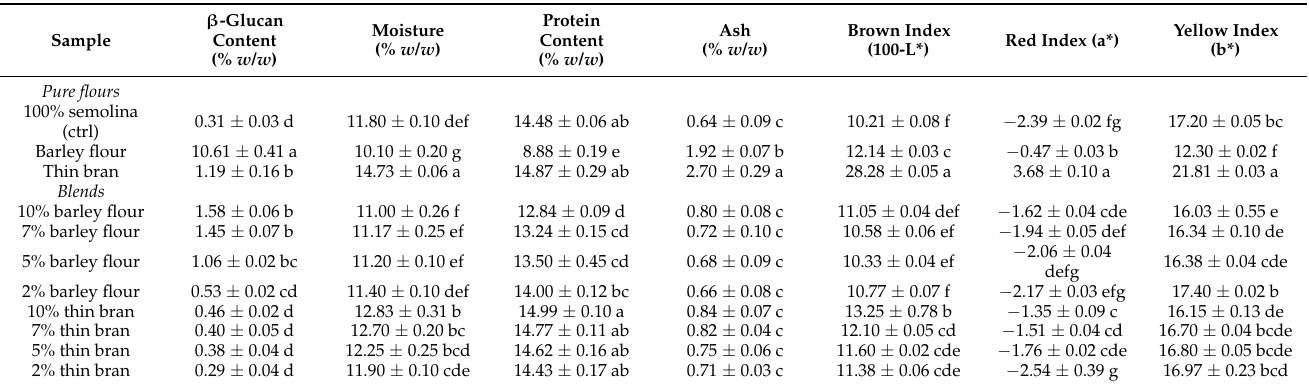
Table 1. Physicochemical features of raw materials and flour blends: one-factor ANOVA (analysis of variance) (data are means ± standard